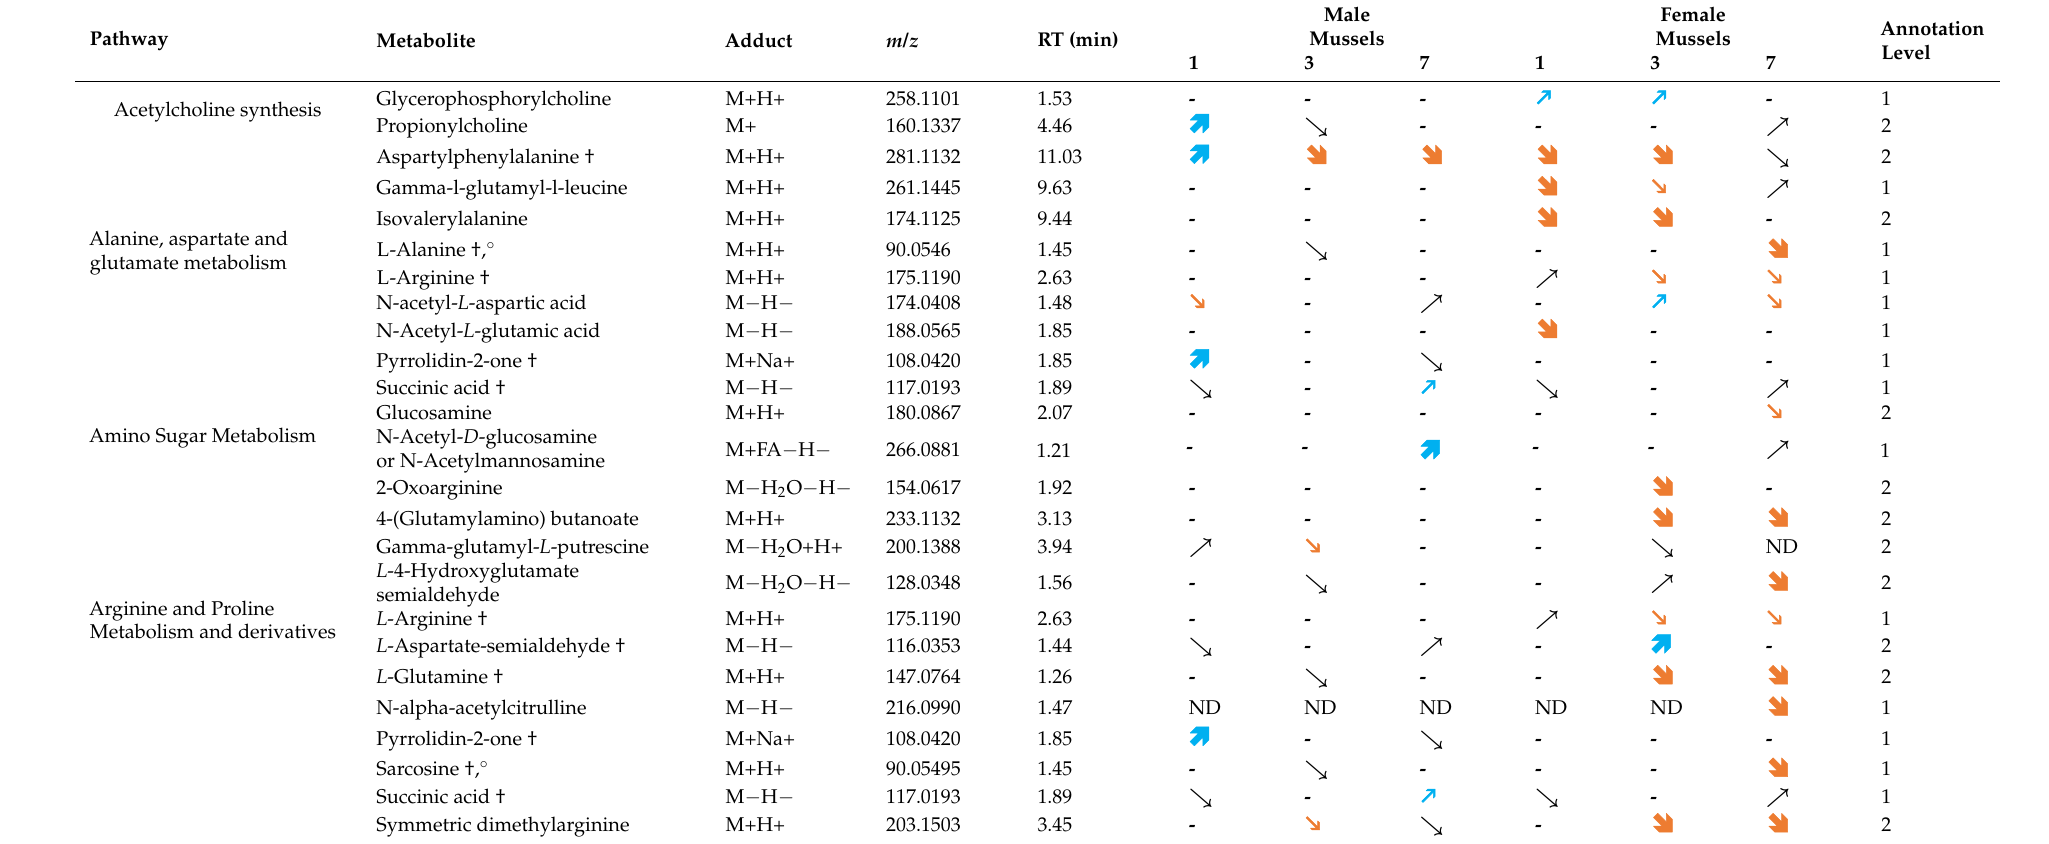
Table 1. Modulated metabolites sorted by their metabolic pathway (only pathways with at least 2 impacted metabolites are represented), for male and female mussels after 1, 3, and 7 days of exposure to VLF (†: metabolites present in several pathways; ◦ : L-alanine and sarcosine could not be differentiated). Colored bold arrows represent significant modulations ( p < 0.05; modulations > 20%), colored thin arrows represent a modulation trend ( p < 0.1; modulations > 20%), and thin, black arrows are non-significant modulations ( p > 0.1; modulations > 20%). Up arrows represent up-modulations and down arrows are for down-modulations. Dashes represent signals with a modulation < 20% and are considered as not modulated. ND: Not detected. RT: Retention